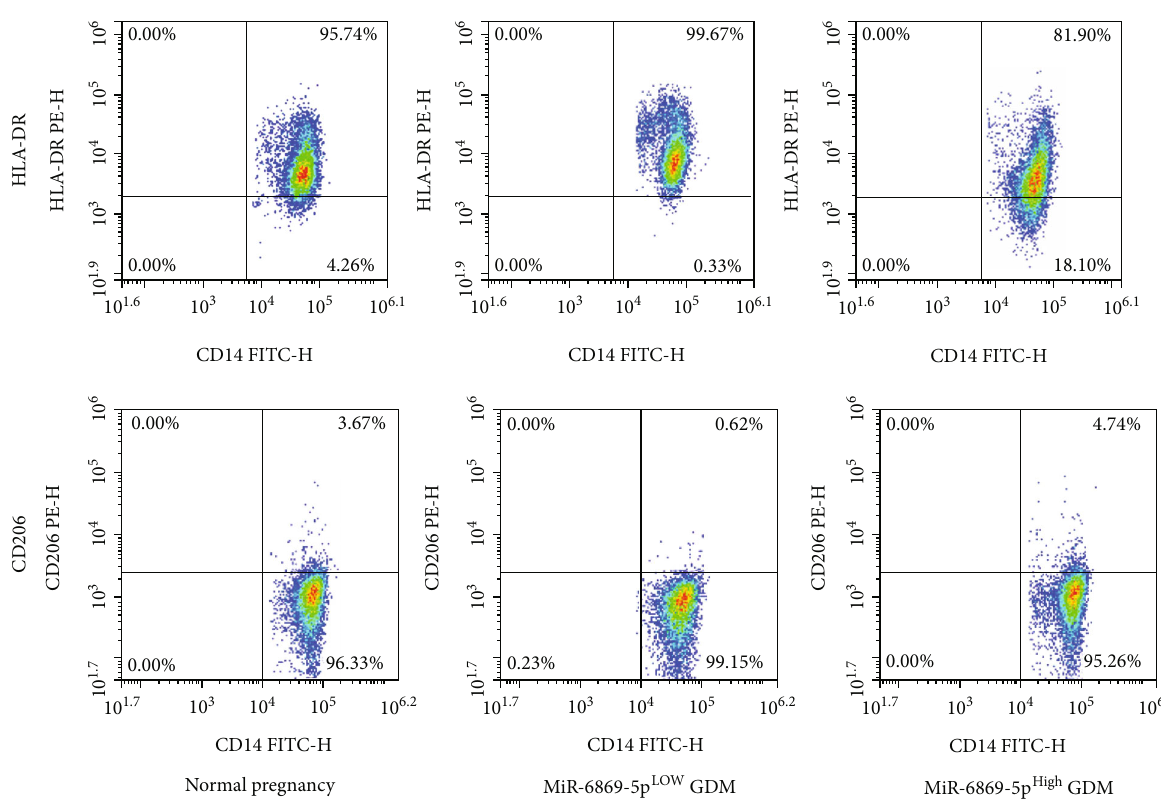
Figure 2: Ratio of CD206 + macrophages and HLA-DR + macrophages in placenta of GDM patients compared with normal